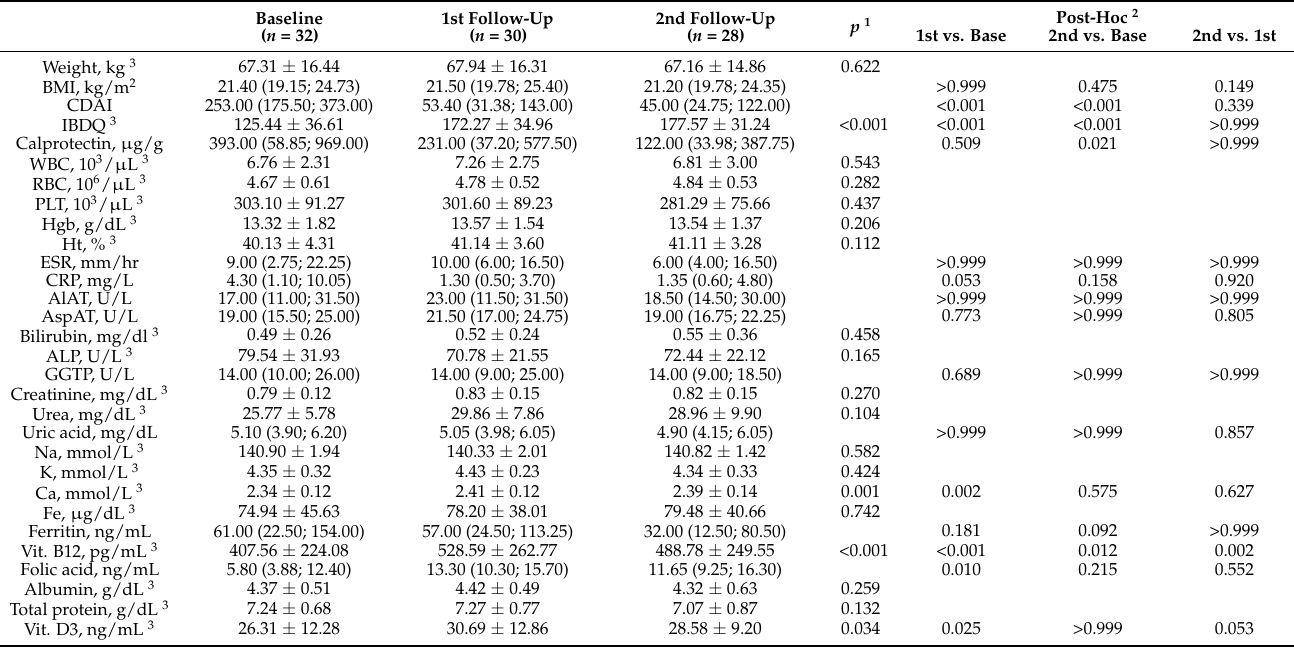
Table 2. Analysis of changes in follow-up